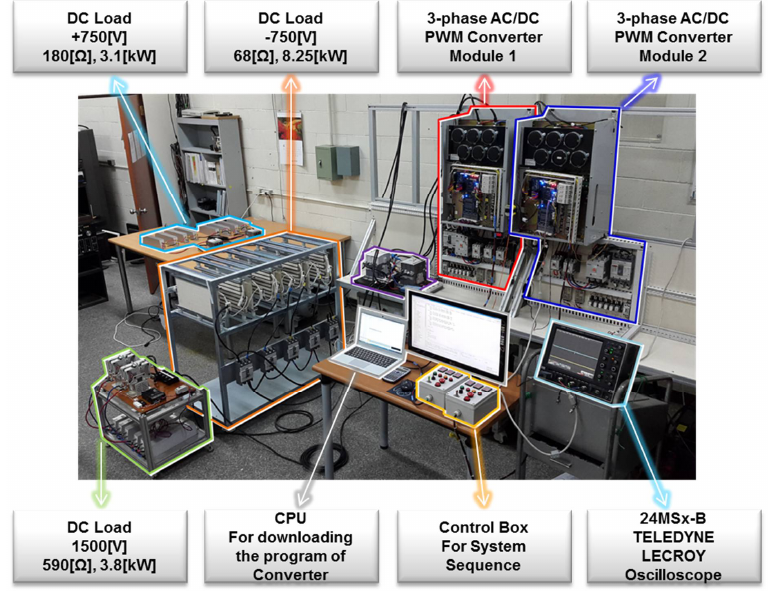
Figure 12. Hardware configuration.